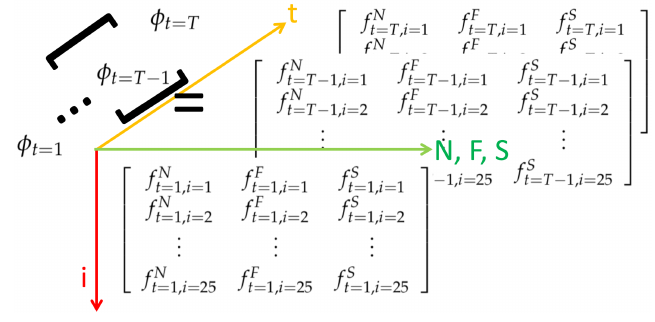
Figure 5. Feature space, camera